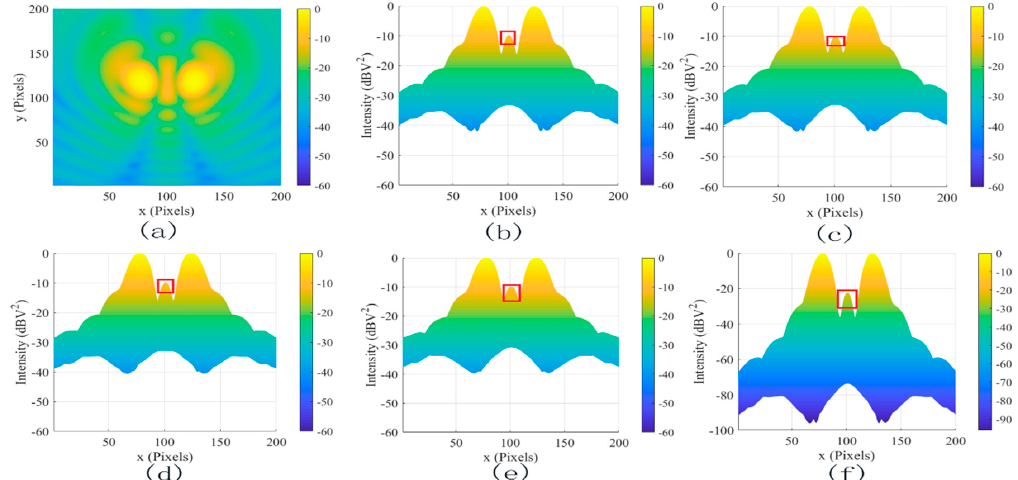
Figure 6. The filtered results for two dipole sources at 2 GHz. ( a ) The original image, ( b ) the lateral view of (a), ( c ) SDC, ( d ) MLG, ( e ) sparse analysis model (SAM), and ( f ) proposed.